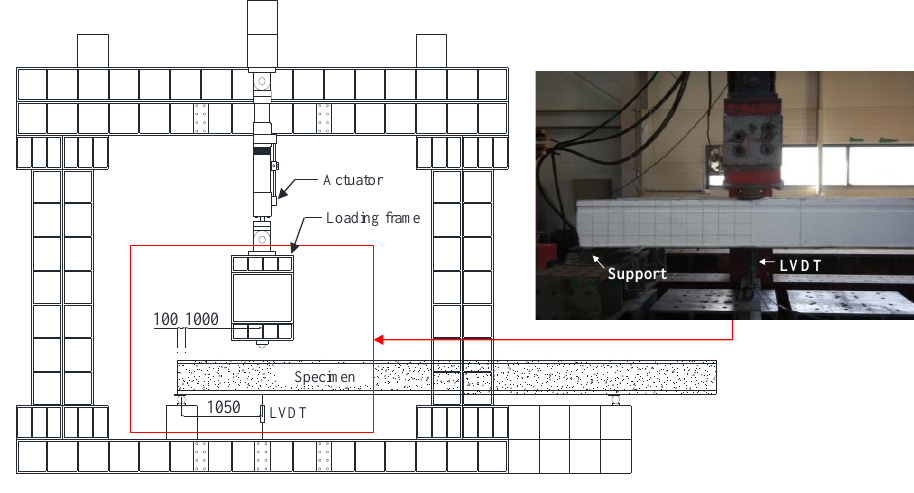
Figure 4. Test setup (Unit: mm).